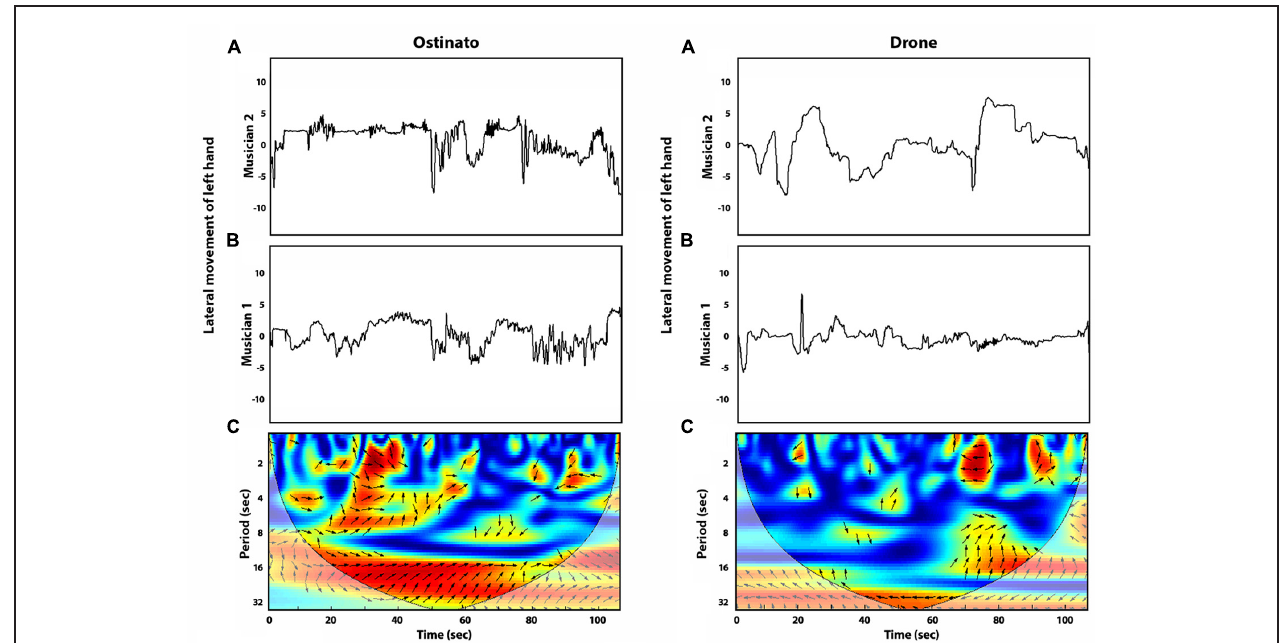
FIGURE 2 | Cross wavelet analysis of experimental data from two piano players improvising with an ostinato backing track (Left) and drone backing track (Right). (A , B) display the normalized time series of the lateral movements of the musicians’ left hands. (C) Cross wavelet analysis of these